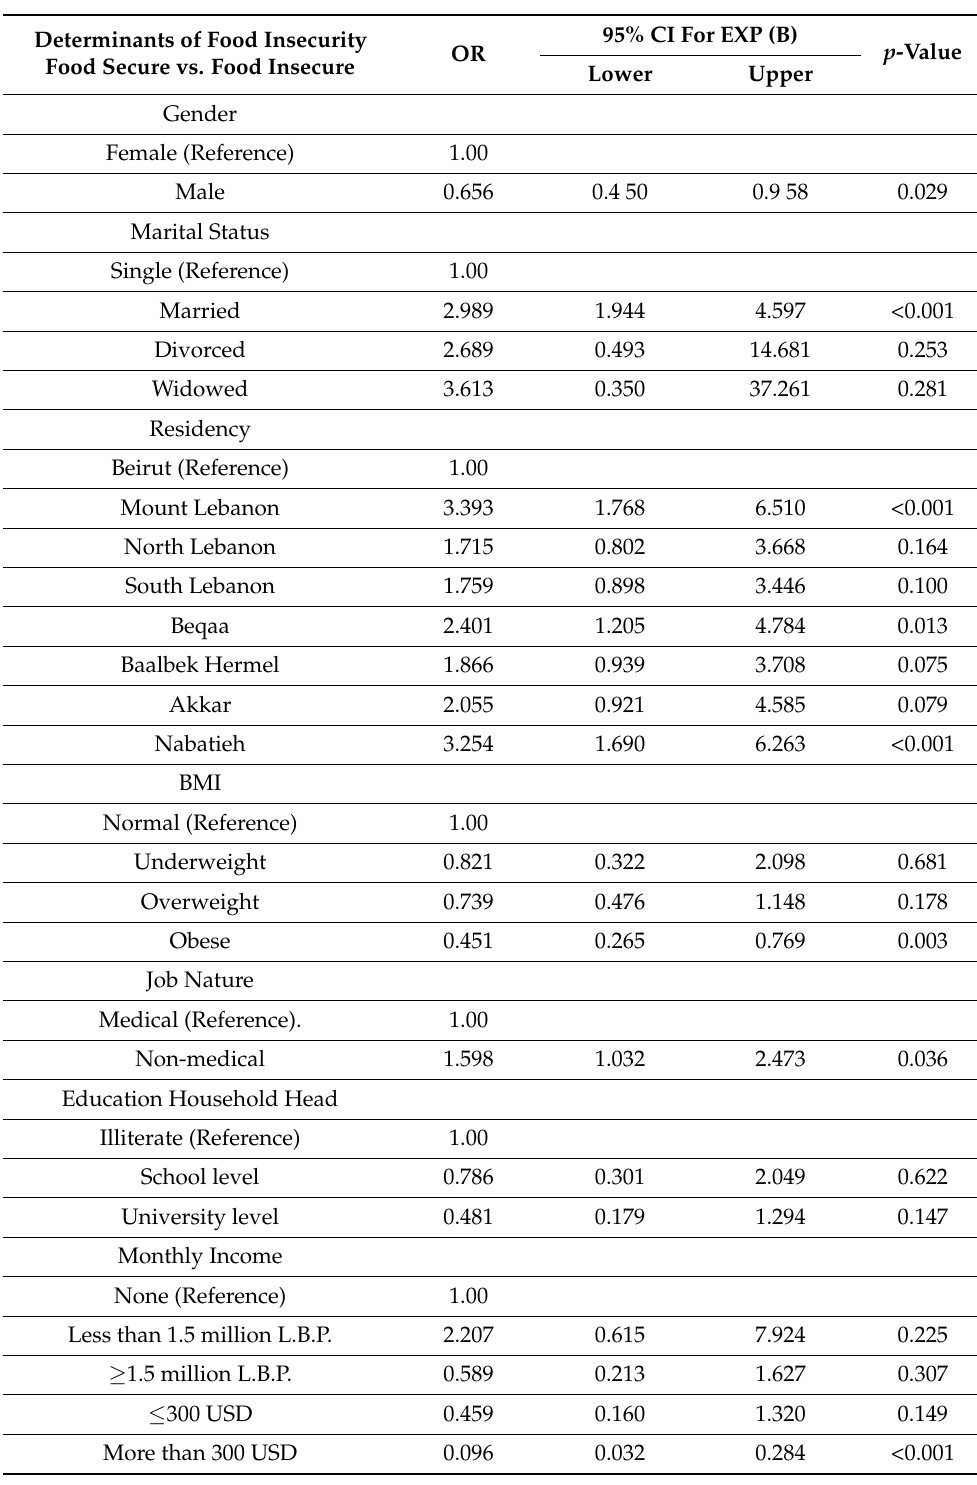
Table 6. The determinants of Households’ Food Insecurity based on the Logistic Regression analysis (Backward stepwise